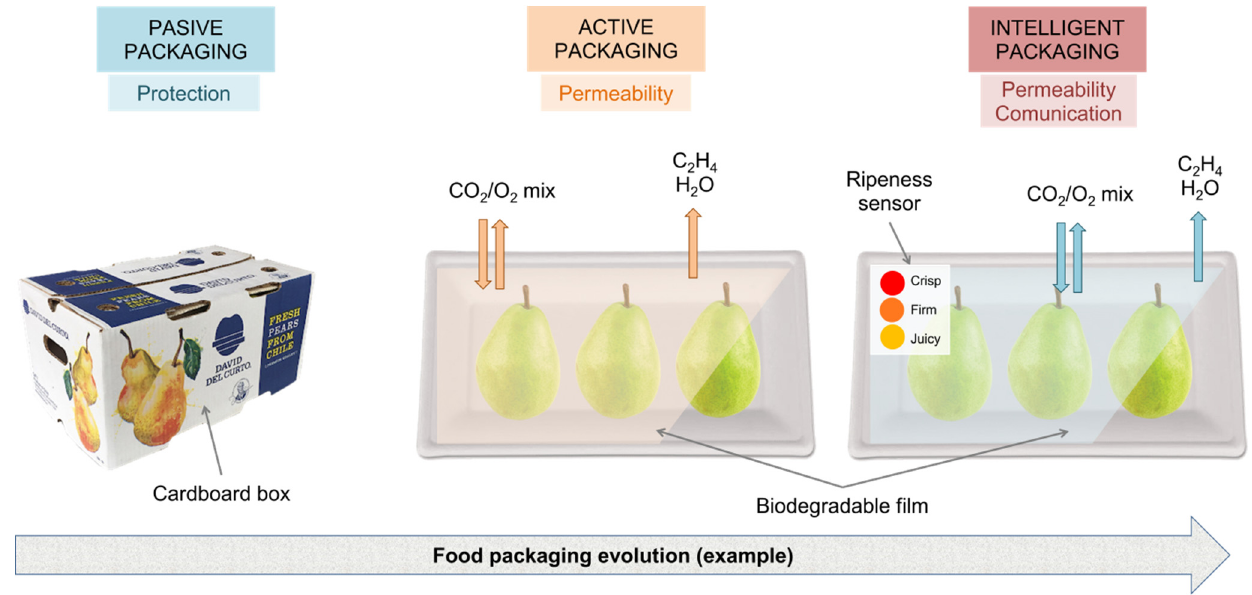
Figure 3. Schematization of the evolution of food packaging.